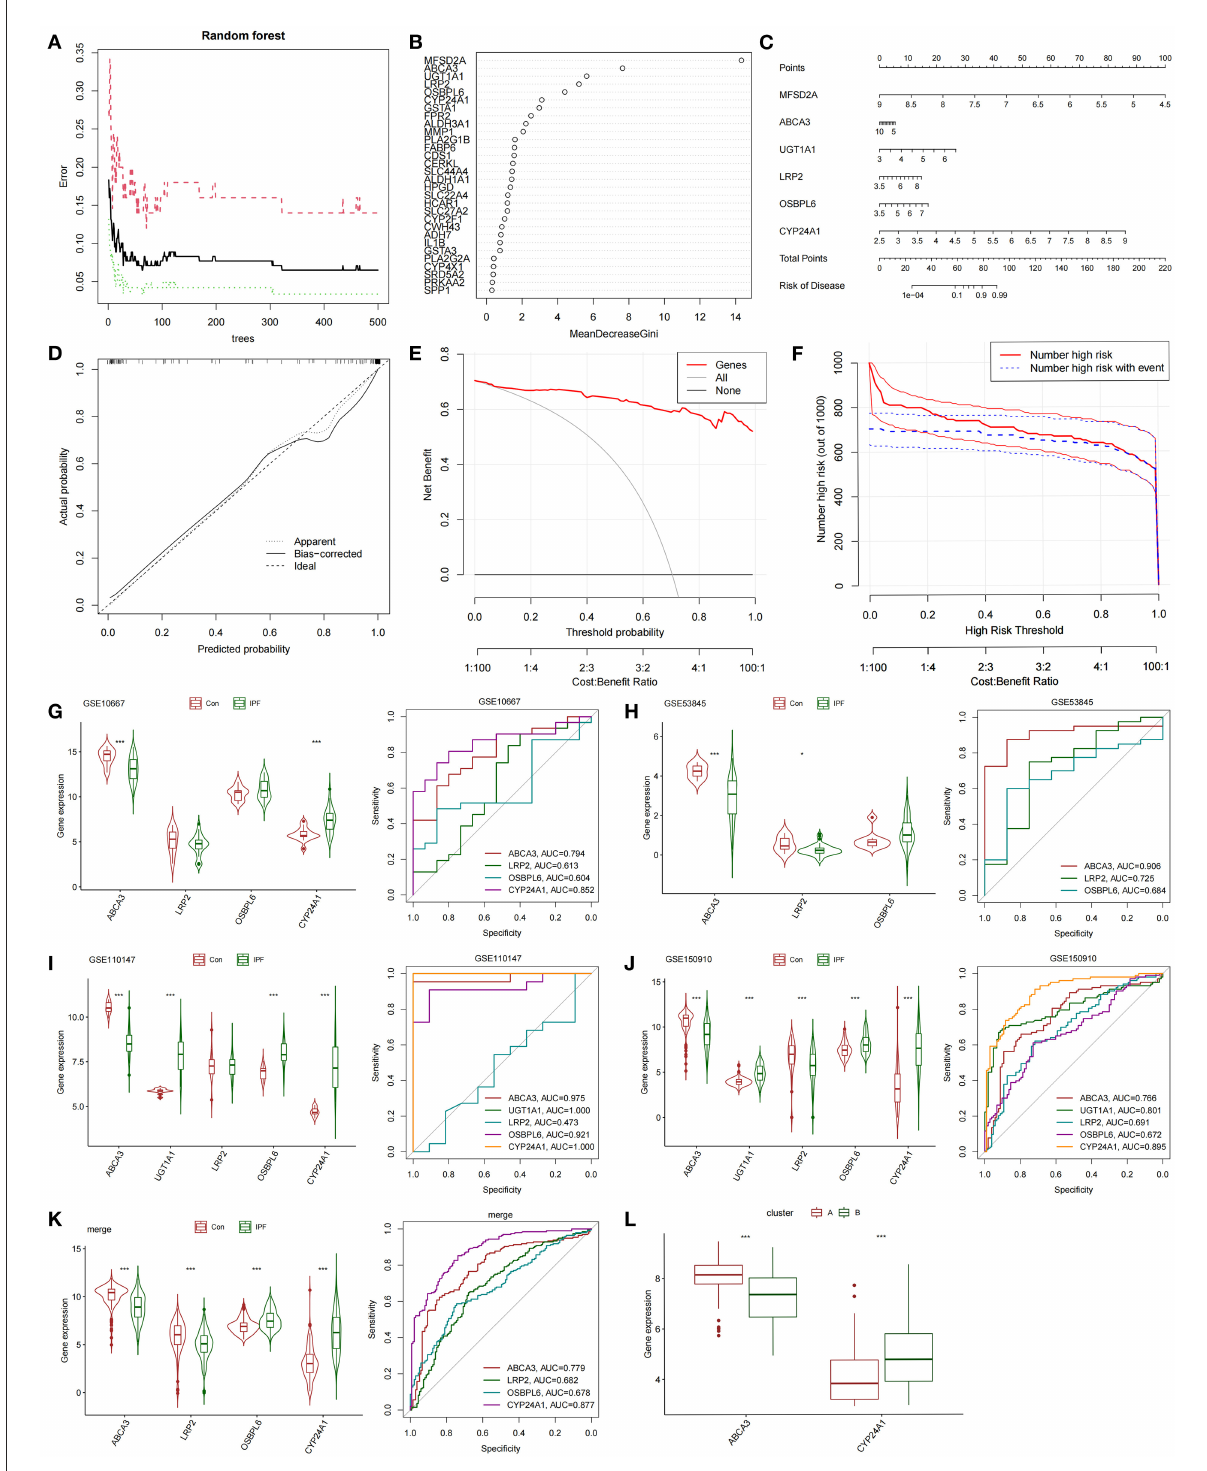
FIGURE3 Construction and validation of diagnostic lirogram model. (A) Random forest tree constructed by cross validation. (B) Genes ranked in the top 30 by importance score. (C) Rograms were used to predict different fatty acid metabolism levels in IPF patients. (D) Calibration curves to assess the predictive power of the line-graph model. (E) DCA curve to evaluate the clinical value of the lipopograph model. (F) Evaluate the clinical impact curve of the lipopograph model based on DCA curve. (G) Expression levels and diagnostic efficacy of model key genes in dataset GSE10667. (H) Expression levels and diagnostic efficacy of model key genes in dataset GSE53845. (I) Expression levels and diagnostic efficacy of key genes in the model in dataset GSE110147. (J ) Expression levels and diagnostic efficacy of model key genes in dataset GSE150910. (K) Expression levels and diagnostic efficacy of key genes in the model in the four combined data sets. (L) Expression levels of ABCA3 and CYP24A1 in subtypes A and